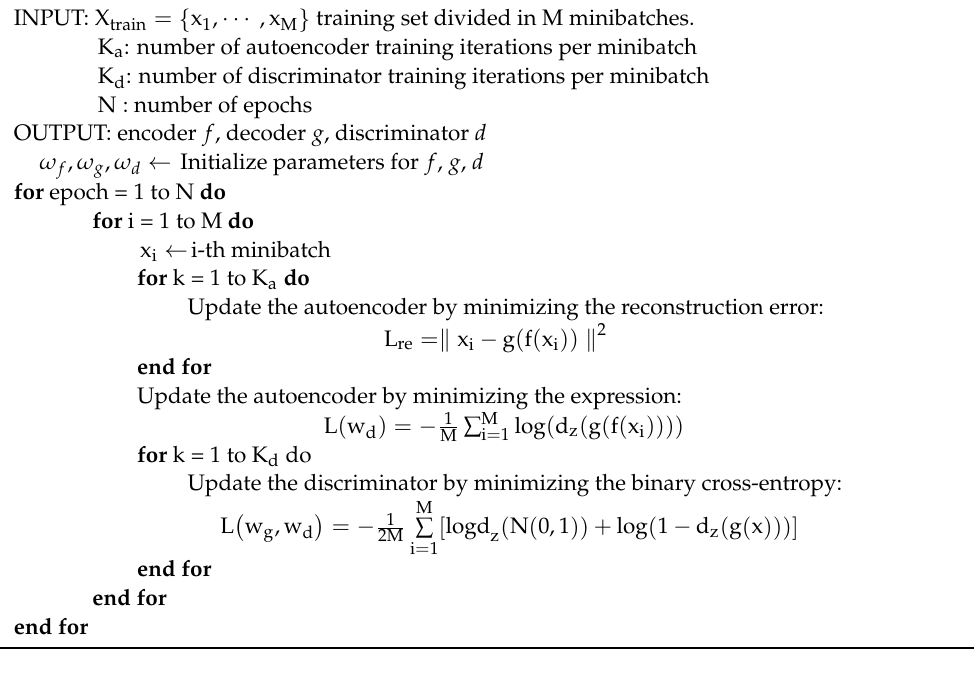
Algorithm 3: 1DAAE training